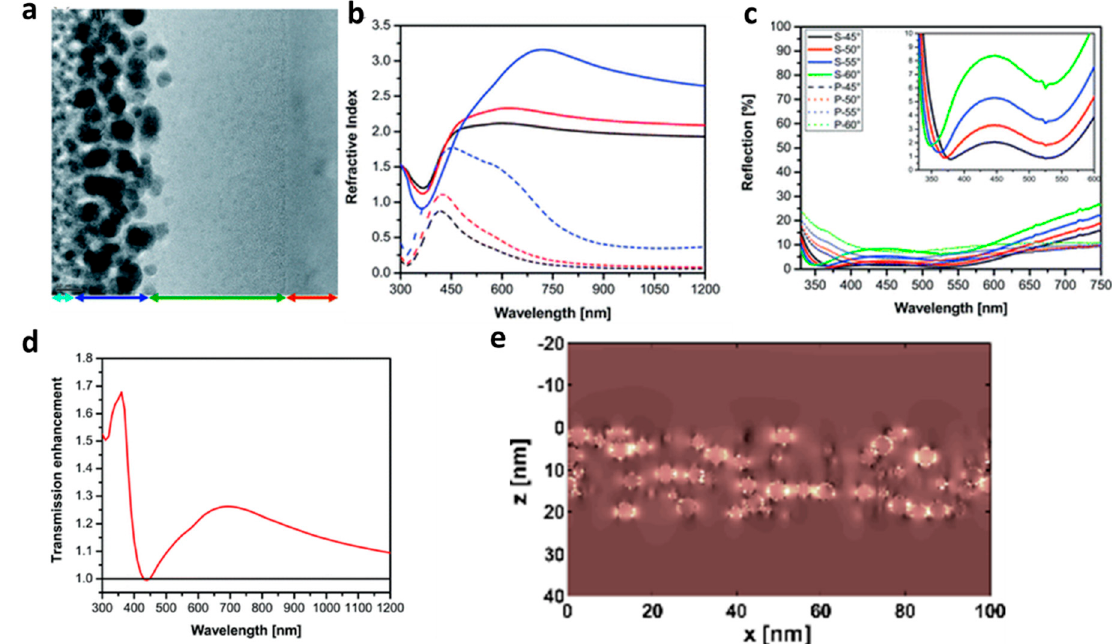
Figure 8. ( a ) Cross-sectional image of plasmonic nanocomposite in which the arrows indicate each of the samples. Light blue, blue, green and red arrows represent the platinum (top adhesion layer for cutting of the sample), nanocomposite, SiO 2 layer and silicon wafer, respectively; ( b ) Complex refractive index of the Ag–SiO 2 nanocomposite with 15% (black), 20% (red) and 40% (blue) filling factors. Solid and dotted lines represent the real and imaginary parts of RI, correspondingly; ( c ) Reflection spectra of 20 nm Ag–SiO 2 with 20% (red) and 30% (blue) filling factors deposited atop 50 nm SiO 2 -coated silicon measured at different angles of incidence with s—(solid lines) and p—polarization (dotted lines); ( d ) Calculated transmission enhancement of silicon by plasmonic coating, which is calculated by normalization of the transmission of coated silicon in comparison to the bare one. The black line shows the normalized transmission of bare silicon while the red curve is the normalized transmission of the Ag–SiO 2 nanocomposite deposited on SiO 2 -coated silicon (adapted with permission from [142]; Copyright 2014, Royal Society of Chemistry); ( e ) Amplitude of the electric field in a cross-section through the plasmonic nanocomposite (between z = 0 nm and z = 20 nm). The incident’s linearly polarized plane wave propagates in the + z -direction. The plasmonic nanocomposite has a filling fraction of 20% and consists of randomly arranged non-touching silver nanospheres with a diameter of 4.1 nm embedded in a generic mondisperse dielectric material ( ϵ = 2.25). The amplitude is shown at an incident wavelength of 430 nm. (Adapted with permission from [143]. Copyright 2014, MDPI).